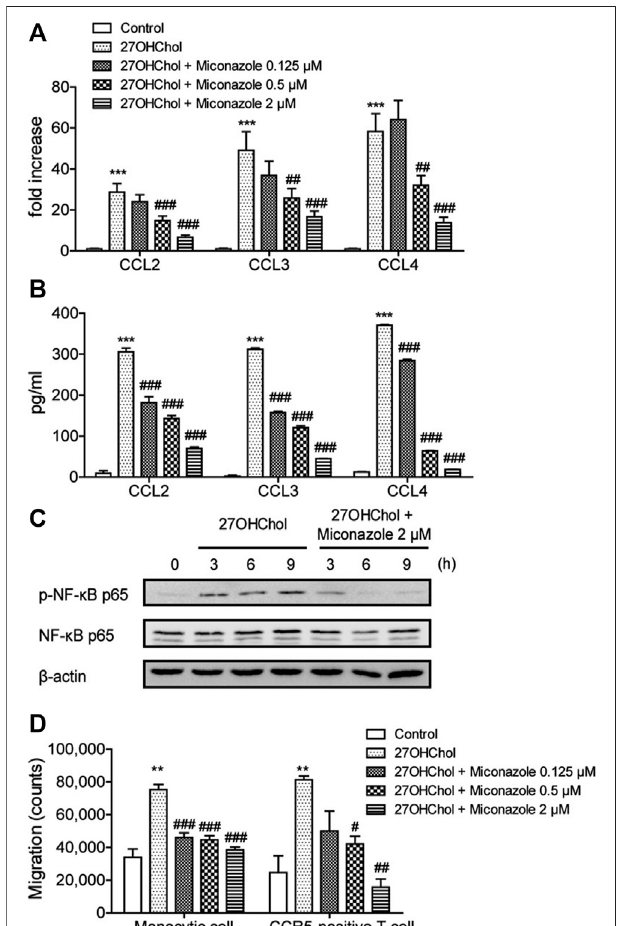
FIGURE 1 | Miconazole downregulates chemokine expression and p65 phosphorylation and decreases immune cell migration. THP-1 cells (2.5 × 10 5 cells/ml) were serum-starved by overnight incubation in RPMI medium supplemented with 0.1% bovine serum albumin (BSA; endotoxin-free), and cultured for 48 h with 27OHChol (2 μ g/ml) in the presence of indicated miconazole concentrations. (A) The transcript levels of CCL2, CCL3, and CCL4wereassessedusingquantitativereversetranscription-PCR.The y -axis values represent the increase in the mRNA levels of indicated genes normalized to GAPDH levels relative to those of the non-treated THP-1 cells (control). (B) Protein levels of CCL2, CCL3, or CCL4 in the media were measured with ELISA. Results are representative of three independent experiments. Data are expressed as mean ± standard deviation (SD) ( n (cid:2) 3 replicates for each group). *** p < 0.001 vs control; ### p < 0.001 vs 27OHChol; ## p < 0.01 vs 27OHChol. (C) Monocytic cells and Jurkat T